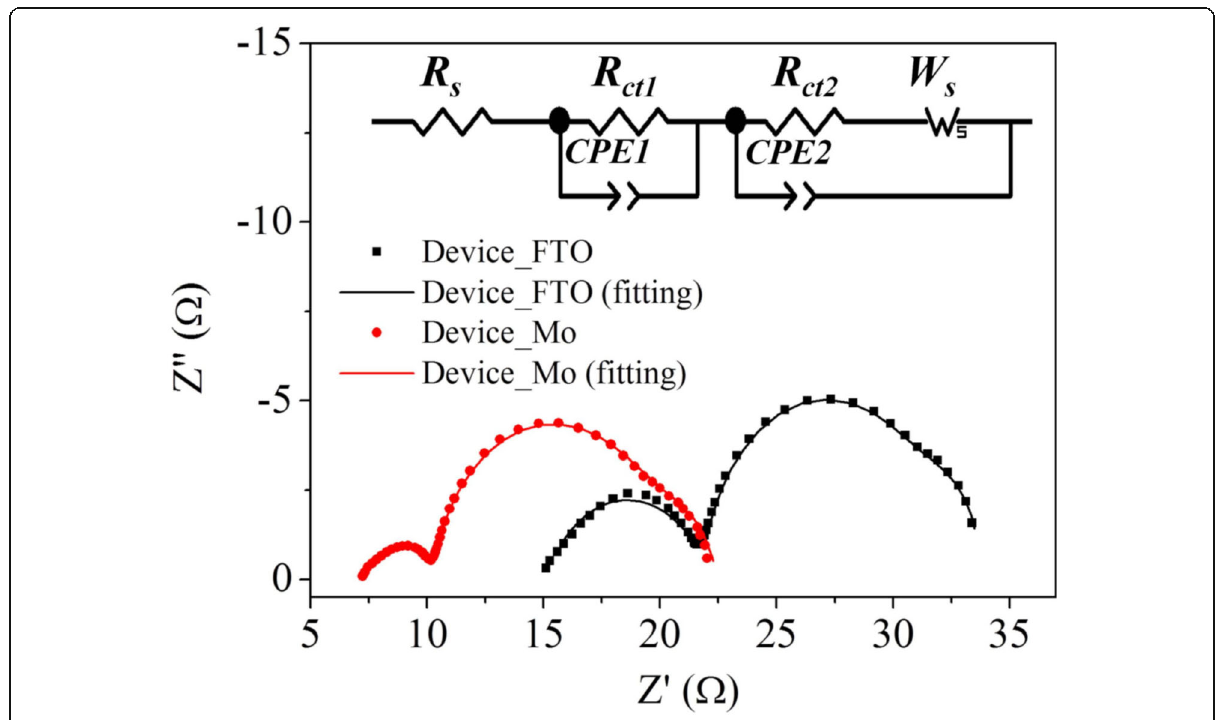
Fig. 8 Nyquist plots of the Device_FTO and Device_Mo. The inset indicates an equivalent circuit model used for the devices [103]